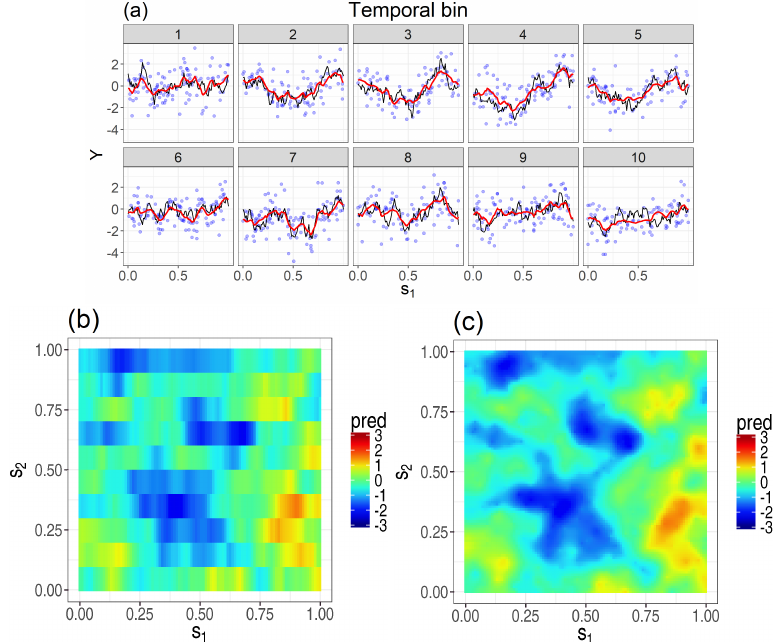
Figure 5. Spatial prediction over s 1 ∈ [ 0,1 ] using data in bins of t (= s 2 ) of width 0.1. ( a ) One-dimensional spatial-only kriging of a two-dimensional field obtained by binning the data into fixed temporal bins (of s 2 ) of width 0.1. The data that fall into the bins are shown as blue dots, the true (unobserved) field at the centre of the bin as a black solid line, and the spatial prediction as a red line. ( b ) The implied two-dimensional spatio-temporal prediction (pred) surface (i.e., assuming temporal invariance within each bin), when carrying out prediction using fixed bins. ( c ) Predictions (pred) obtained by using data in a moving window in s 2 and using optimal prediction for locations at the centre of the moving